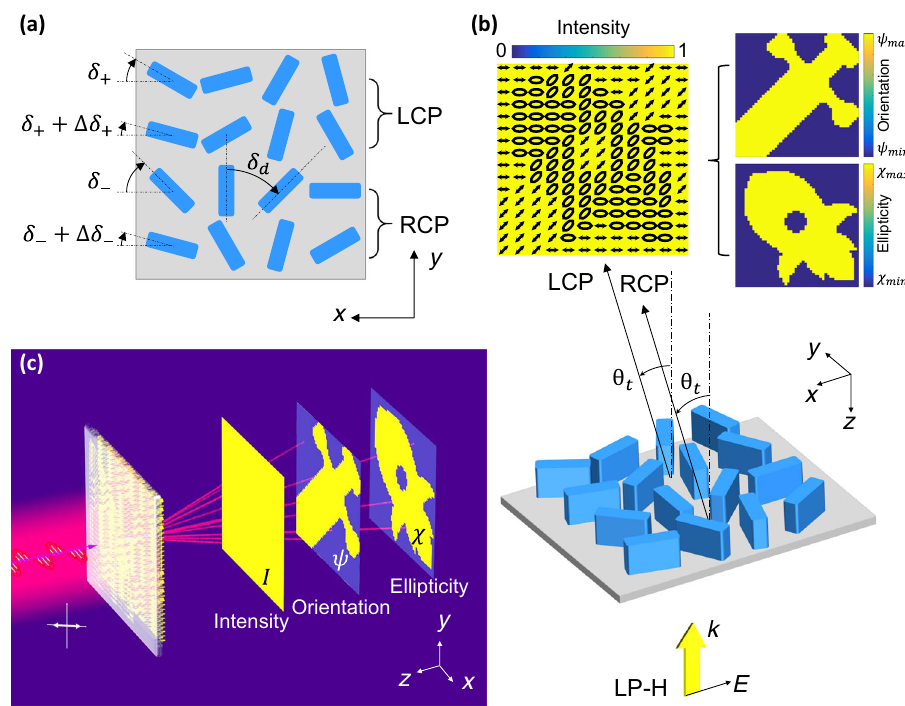
to control the relative amplitude ±